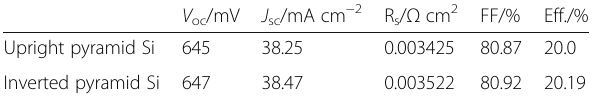
Table 2 Comparison of electrical properties of inverted and upright pyramid sc-Si solar